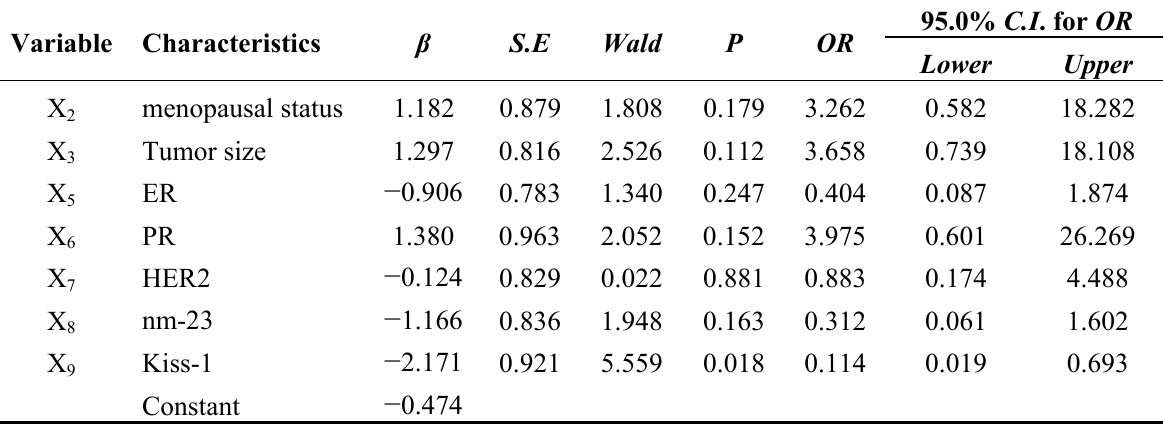
Table 4. Multivariate analysis of clinicopathological data and nodes involvement (n = 50). Variable